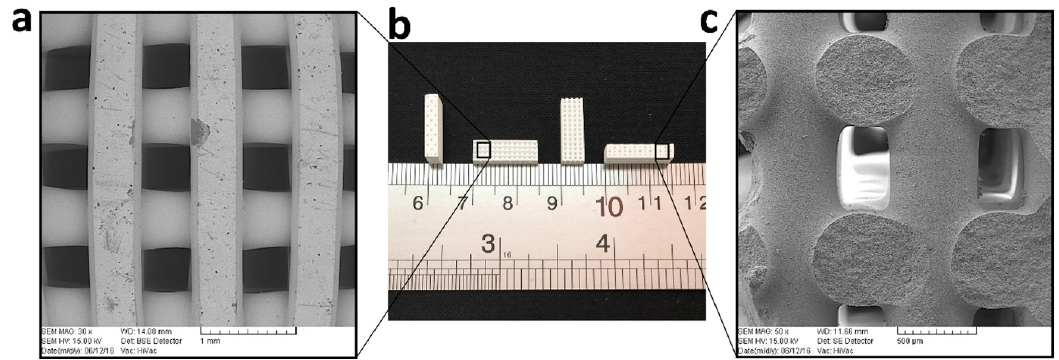
Fig. 10 Sintered printed HA/ β -TCP scaffold: (a, c) SEM micro-graphs of the top view and (b) cross section optical image of the ceramic scaffold. Reproduced with permission from Ref. [101], © Elsevier Ltd and Techna Group S.r.l. 2018.